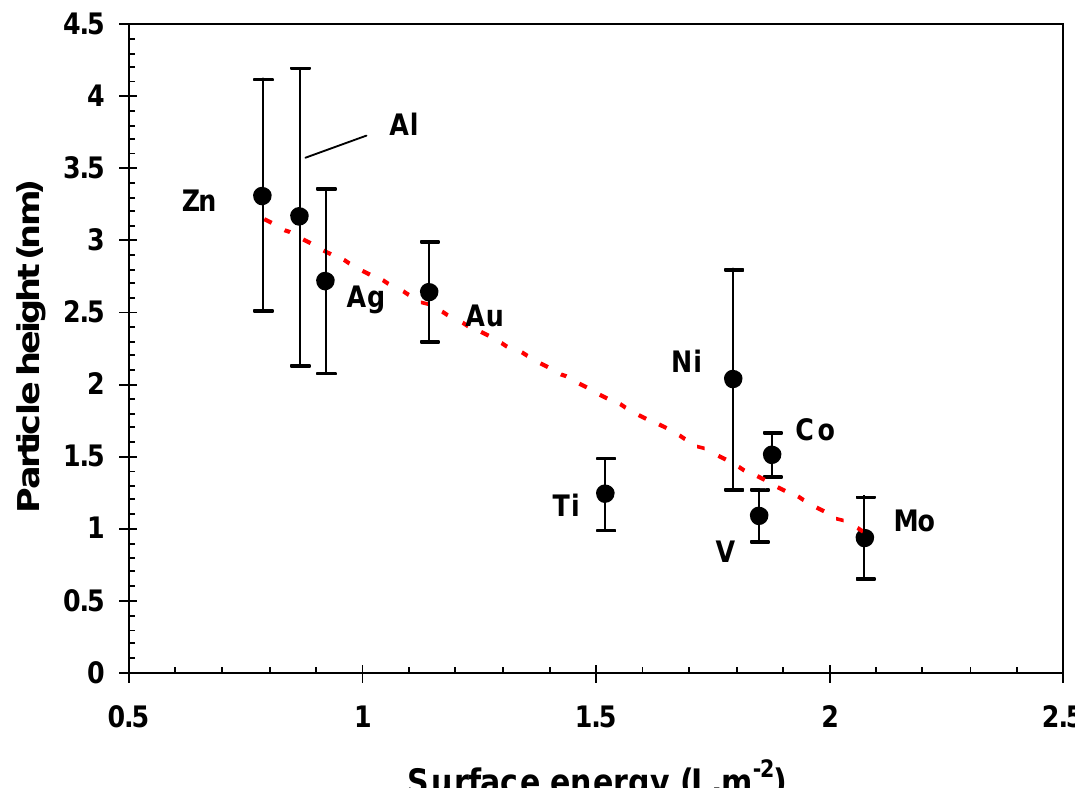
Figure 3. Plot of the height of sparked nanoparticles as a function of surface energy at melting temperature. Figure 4a,d show sparked particle films of gold and cobalt, respectively, on white paper substrates. The film formed in two semicircle shapes with a gap of 1 mm between them. The semicircle on the right-hand side was formed under the cathode and is larger than the semicircle on the left that formed under the anode. This is caused by the process when, during the sparking, atmospheric gas breaks down and creates the positive ions and free electrons. The bombardment of the anode by the electrons and the cathode by the positive ions melts the electrode surfaces. The thermal energy expands, and a shock wave forms. The resulting high air pressure pushes the melted metal layer away from the electrode gap, and the molten metal therefore splashes away from the gap in a cone-shaped pattern, while the nanoparticles are nucleated. The cone shaped splashing produces the two semicircles on the substrate. The black color of the sparked cobalt film in Figure 4a indicates the presence of cobalt oxide. Furthermore, the sparked gold film is pink, which is a feature of gold nanoparticles [17]. Figure 4b,c show the cobalt anode and cathode electrode tips, respectively, after the sparking process. The erosion of the tip results in the round shape at both tip ends. The results are not the same for the gold anode and cathode tips, as shown in Figure 4e,f, respectively. The sparked gold tips are cone shaped. The cone angle of the anode tip is less than that of the cathode tip. The reduced cone angle of the anode tip corresponds with the smaller area of the particle film produced under the anode (Figure 4d). The shape of the anode is caused by the expansion of the plasma diameter at the anode surface [18]. In addition, the sides of the cobalt tips were covered by nanoporous films. It is believed that some of the metal evaporated as a gas phase and then deposited on the tip surfaces. The sides of the gold electrodes are different from those of the cobalt tips and no deposited nanoporous film was observed because the gold vapor could not oxidize in this